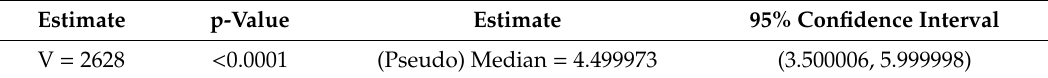
Table 1. Wilcoxon statistical test of results using distinct multipatch resolution. Estimate